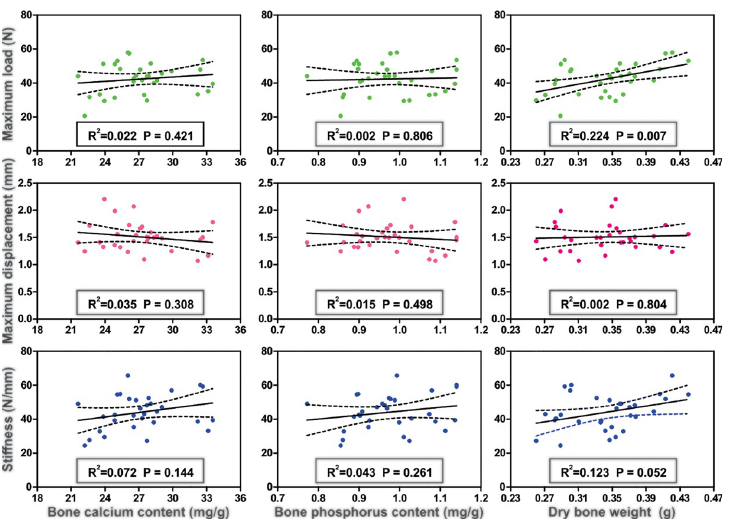
Fig 2. Correlations between bone characteristics in Artibeus lituratus females. Correlation between bone calcium, bone phosphorus and dry bone weight with bone strength parameters in Artibeus lituratus females. Black lines represent regression line and dotted lines represent 95% confidence limit.